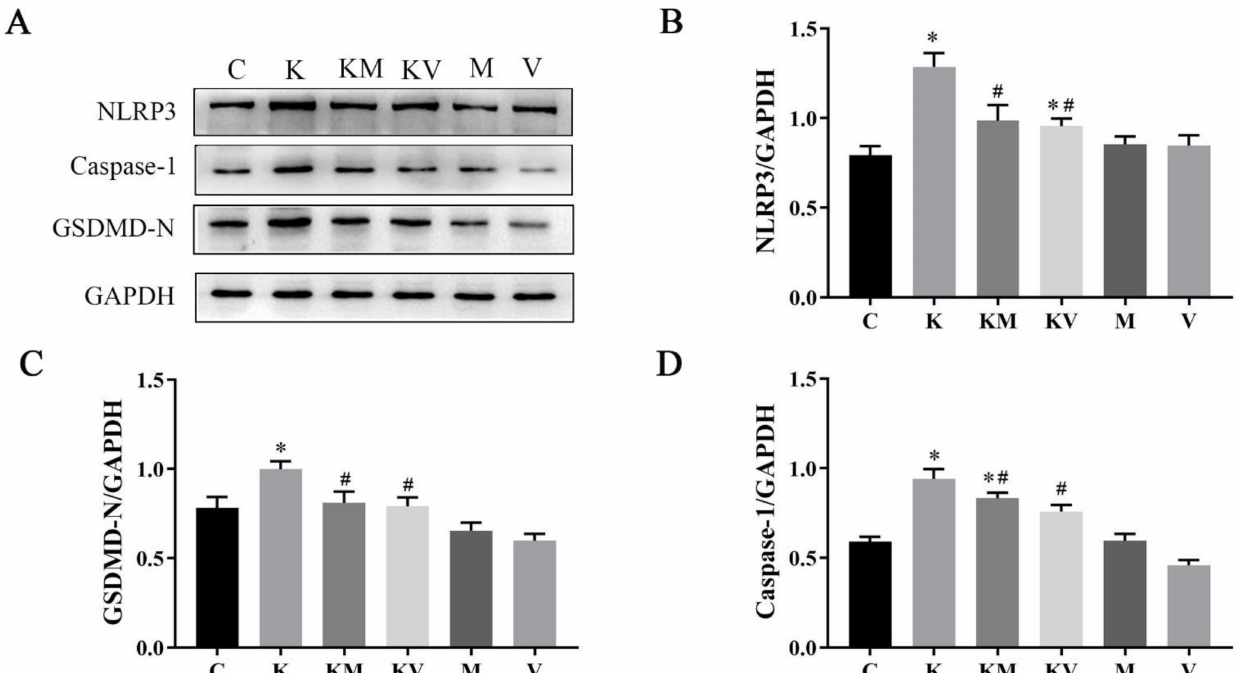
Figure 5. Effects of MCC950 and VX765 on ketamine induces pyroptosis in liver of neonatal rats. ( A ) Western blotting bands and ( B , C and D ) representative image for NLRP3-3, Caspase-1 p20, and GSDMD-N ( n = 3). Results are the mean ± SD. * p < 0.05 vs. control group; # p < 0.05 vs. ketamine